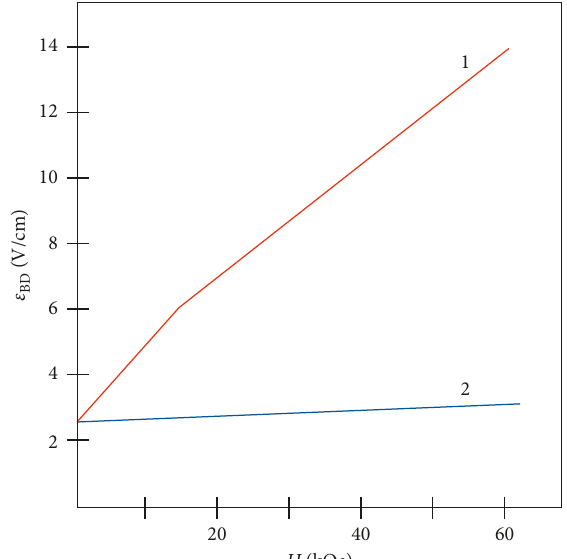
Figure 2: Dependence of the breakdown electric field ε magnetic field H for different n-GaAs samples when the electric ε and magnetic H fields are (1) perpendicular ε ‖ H each other. A weak dependence of ε ε BD by an error in the setting of a rotation angle of the